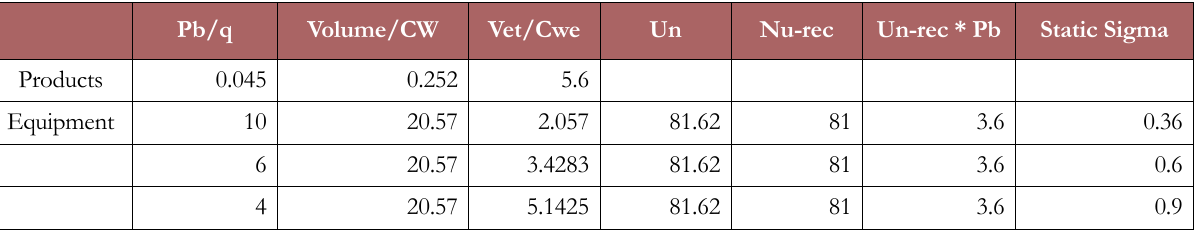
Table 10. Coefficient of equipment utilization